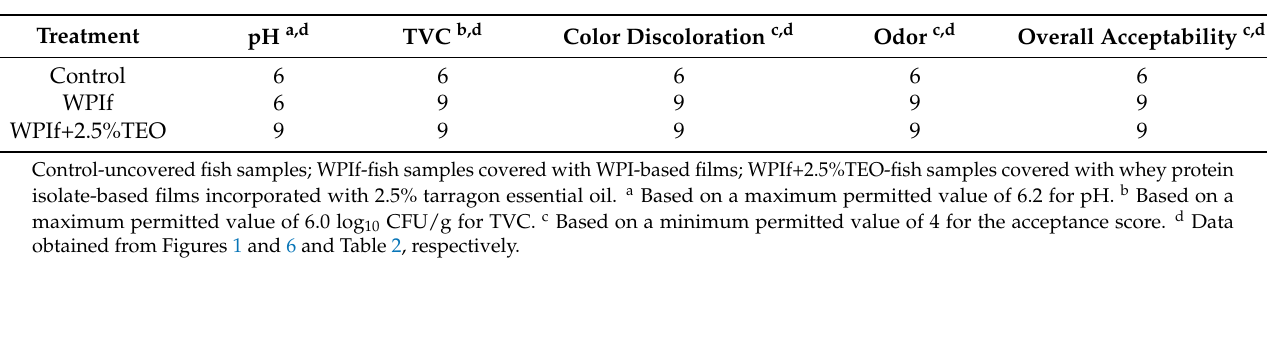
Table 3. Shelf-lives of brook trout samples at refrigerated